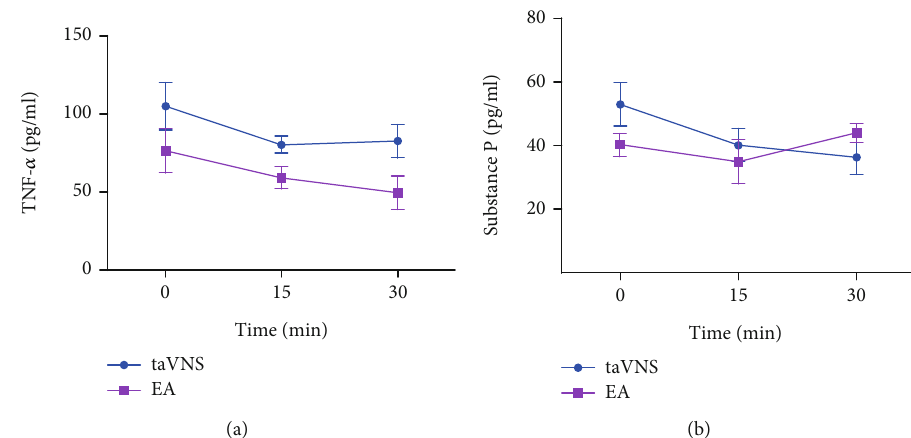
Figure 2: Comparison of plasma concentration of TNF- α and SP in taVNS and EA groups before, during, and after intervention. (a) Comparison of plasma concentration of TNF- α in taVNS and EA groups before, during, and after intervention. (b) Comparison of plasma concentration of SP in the taVNS and EA groups before, during, and after